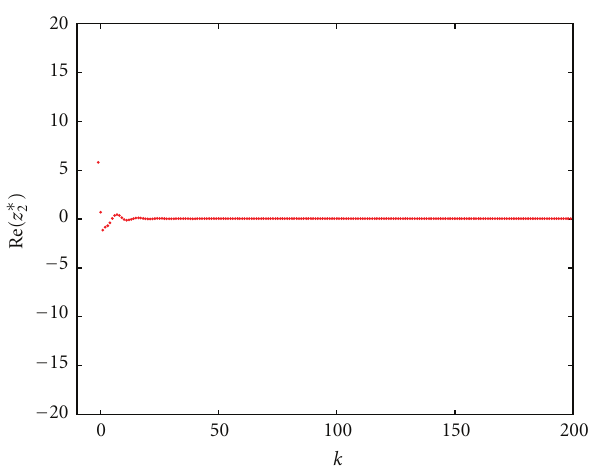
Figure 3: The behavior of the real part of z 2 (cid:5) k (cid:7) .